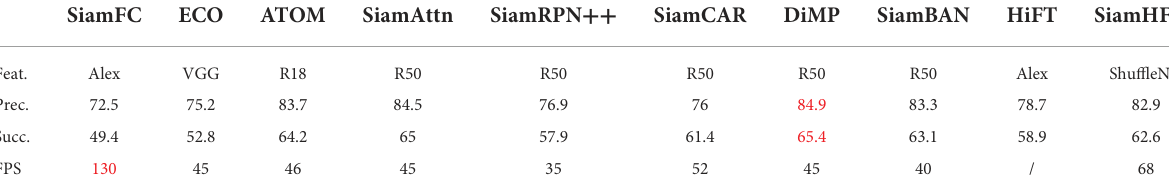
TABLE 1 Quantitative evaluation on UAV123 in term of precision (Prec.), success (Succ.) and GPU speed (FPS). SiamFC